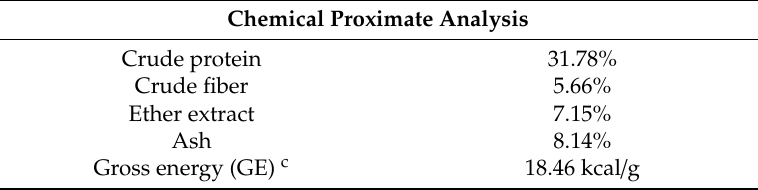
Chemical Proximate